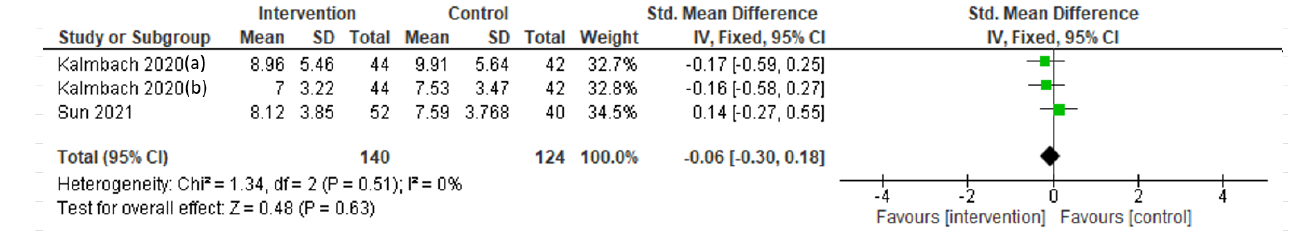
Figure 5 . Sleep quality at the endpoint: Kalmbach 2020 (a, [66]) = ISI; Kalmbach 2020 (b, [66]) = PSQI. Figure 4 . Anxiety symptoms at the endpoint.